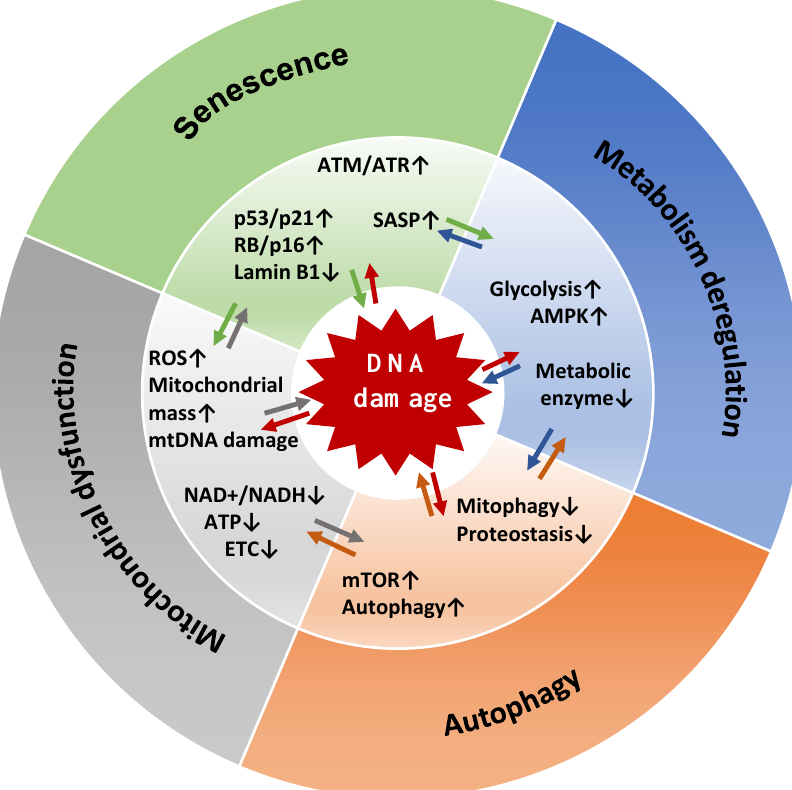
Figure 3. Overview of the mechanisms by which DNA damage promotes senescence. DNA damage (through telomere dysfunction and replicative stress) can result in cellular senescence, mitochon- drial dysfunction, autophagy defects, and metabolic changes. These functional alterations are all interconnected and generate positive feedback signals that induce more DNA damage. This cre- ates a cycle that contributes to stabilize the senescence-related cell cycle exit. AMPK, adenosine monophosphate-activated protein kinase; ETC, electron transport chain; mtDNA, mitochondrial DNA; mTOR, mammalian target of rapamycin; ROS, reactive oxygen species; SASP, senescence- associated secretory